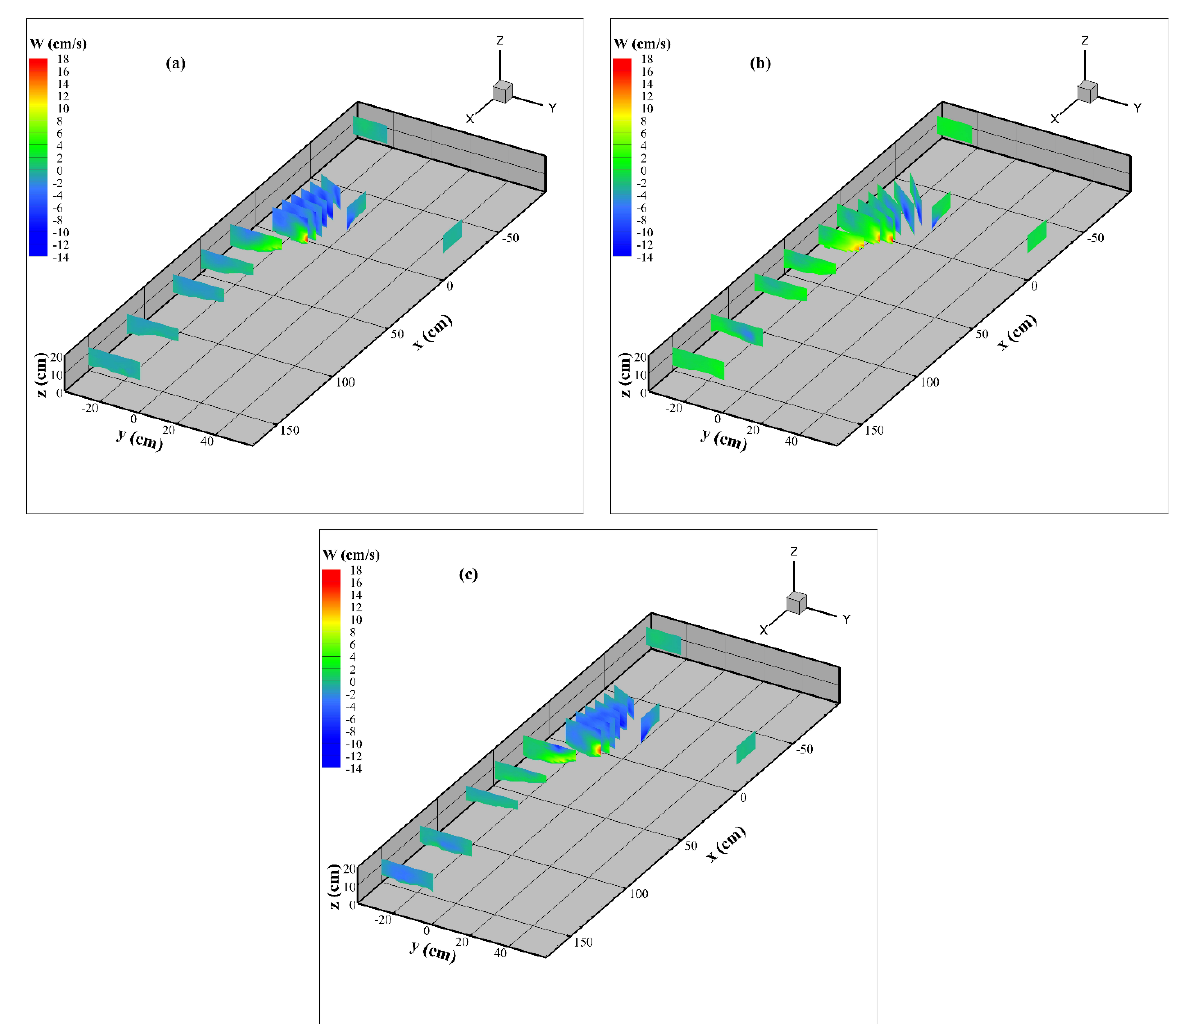
Figure 6. The spatial distribution of vertical velocities W of three cases. ( a ): case 1; ( b ): case 2; ( c ): case 3.